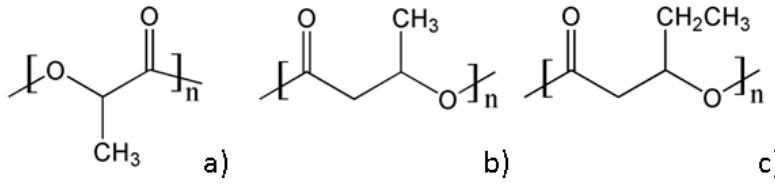
Figure 3. Chemical structures of PLA ( a ), PHB ( b ) and PHV ( c ).